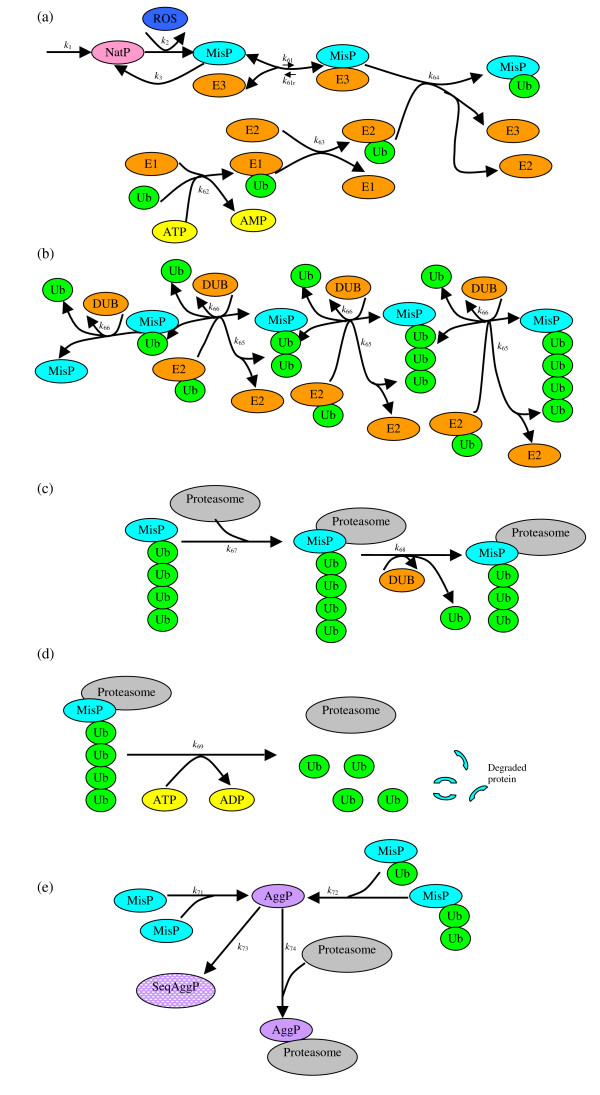
Network diagram of the ubiquitin-proteasome model. (a) Reactions leading to the first ubiquitination step; (b) reactions of chain lengthening and shortening (only shown for chains up to length four); (c) binding of substrate with polyubiquitin chains (of length four or more) to proteasome and chain shortening of bound substrates by DUBs which leads to release from proteasome when chain is less than four; (d) degradation of substrates by proteasome in ATP-dependent manner releasing ubiquitin for recycling; (e) formation of aggregated proteins, sequestering of aggregates and proteasome inhibition by aggregates.